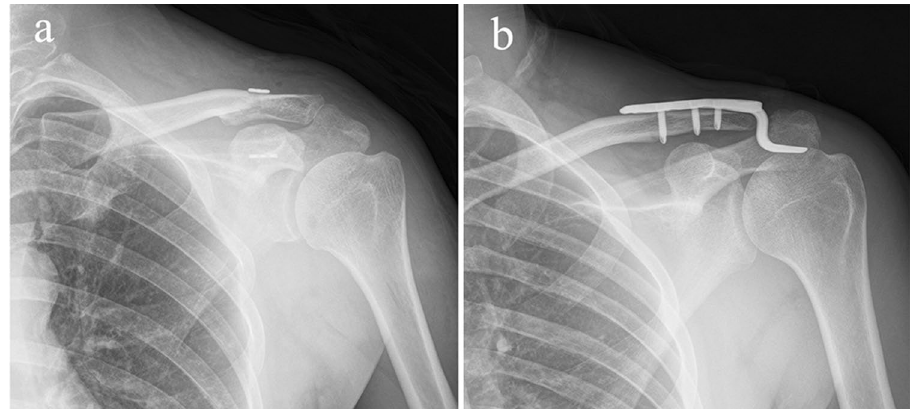
Figure 1. Radiographs immediately after the surgical procedures. ( a ) MITR fixation. ( b ) HP